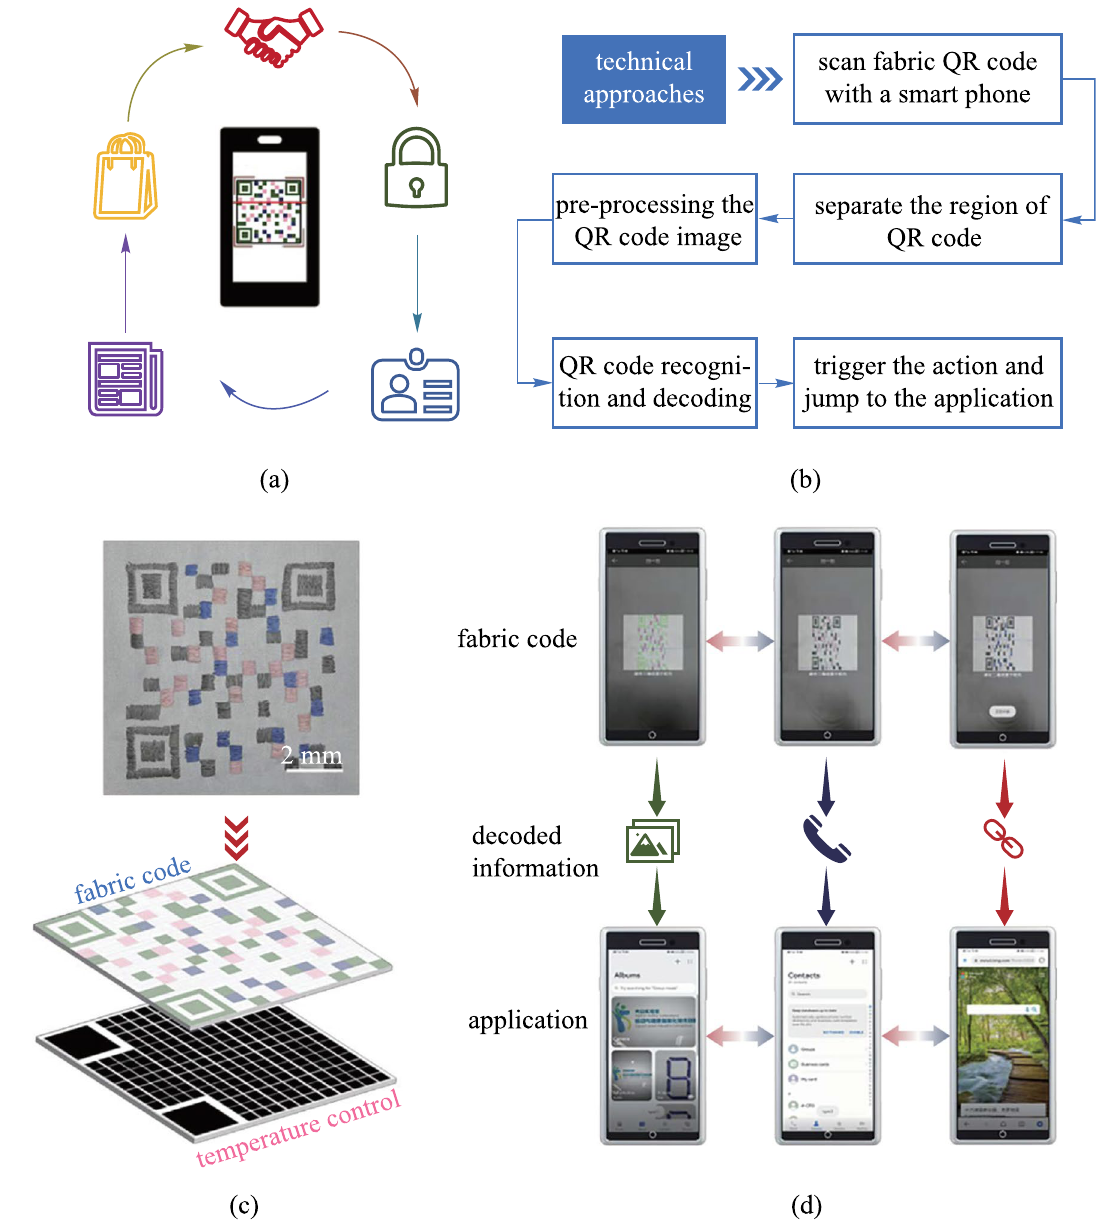
Fig. 4 QR code on fabric for information interaction. a Colored fabric QR codes for various applications. b Basic flow scheme of colored QR code recognition. c Schematic of a heating scheme for dynamic fabric display. d Different information acquired from one fabric displaying three colored patterns at different